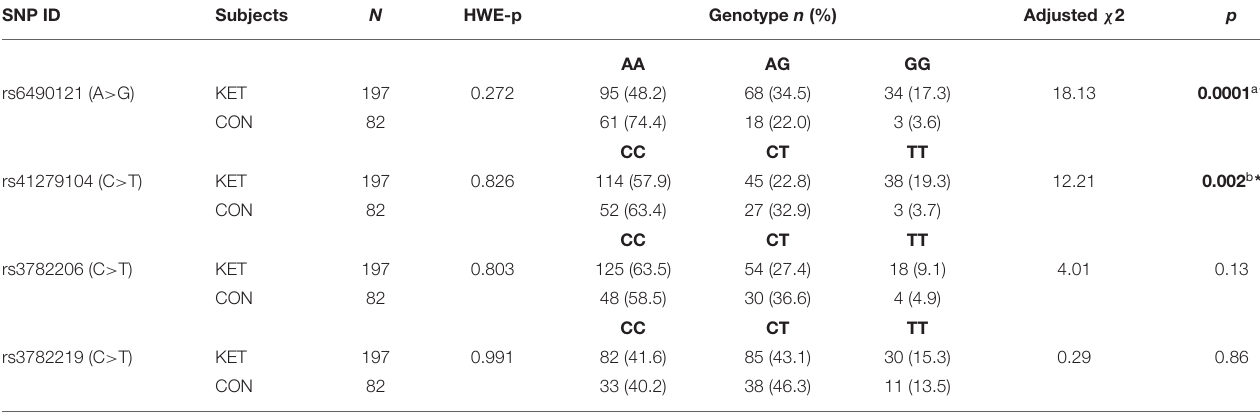
TABLE 2 | Distribution of genotypes of NOS1 gene in ketamine users vs. control subjects.